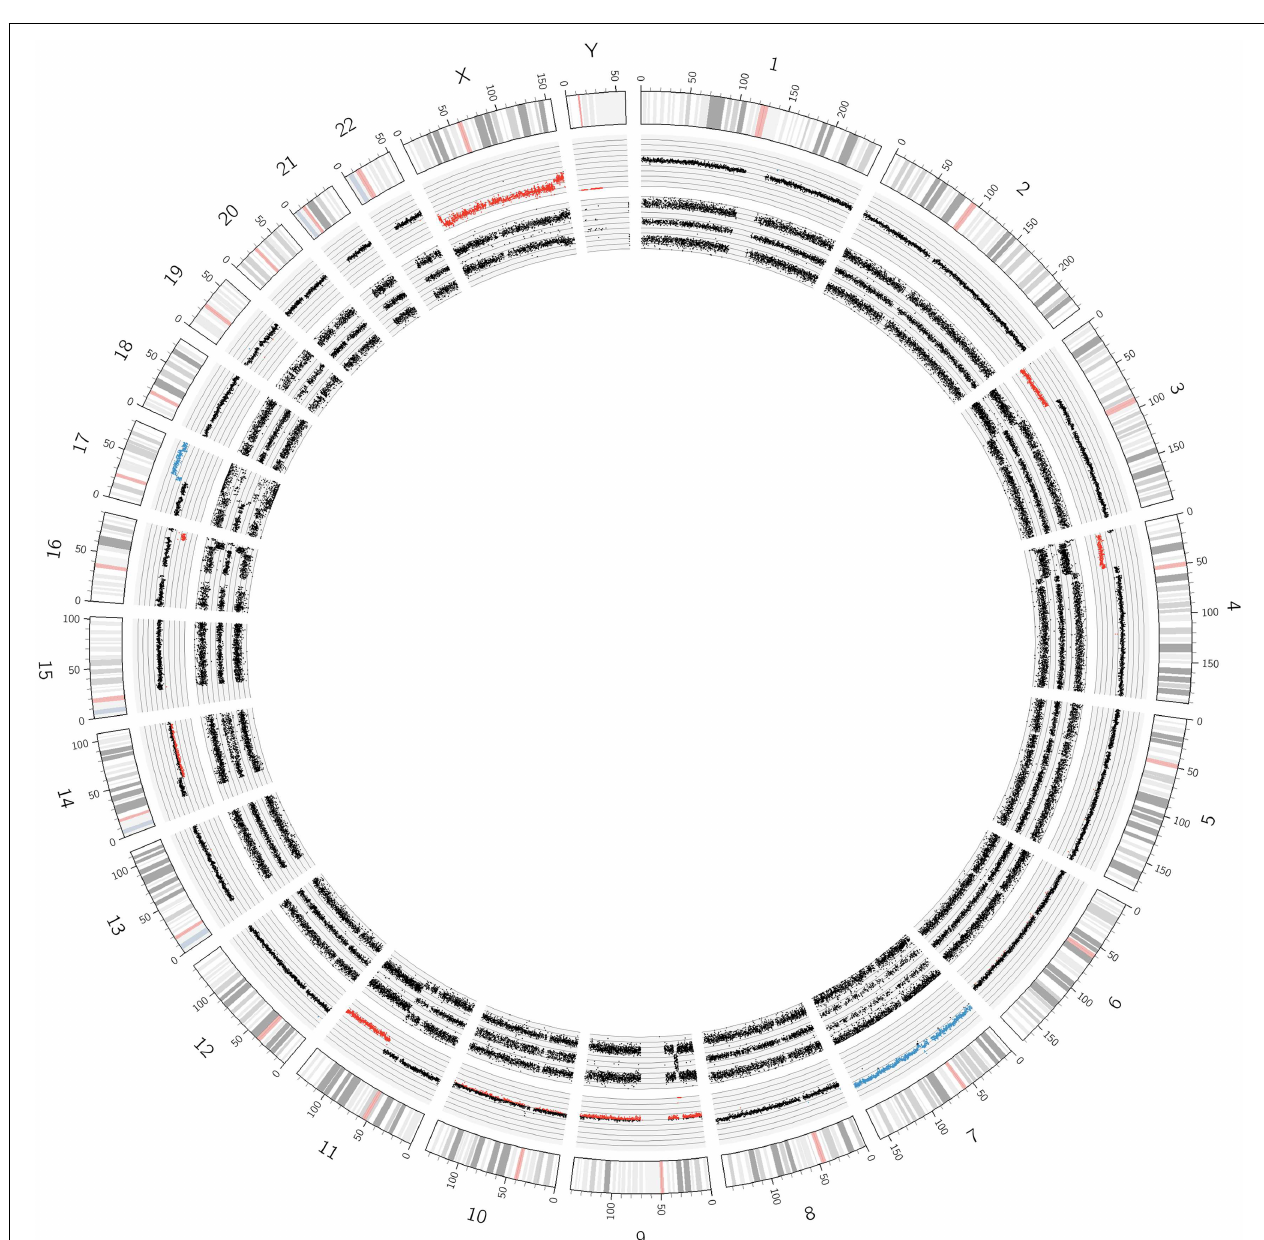
accompanied by LOHes.The chromosome 9 shows a whole chromosome UPD and a 9p21.3 loss resulting in a nullisomy for the genes CDKN2A and 2B . Further segmental aberrations were found on chromosomes 14 and 17. A whole chromosome gain was found for chromosome